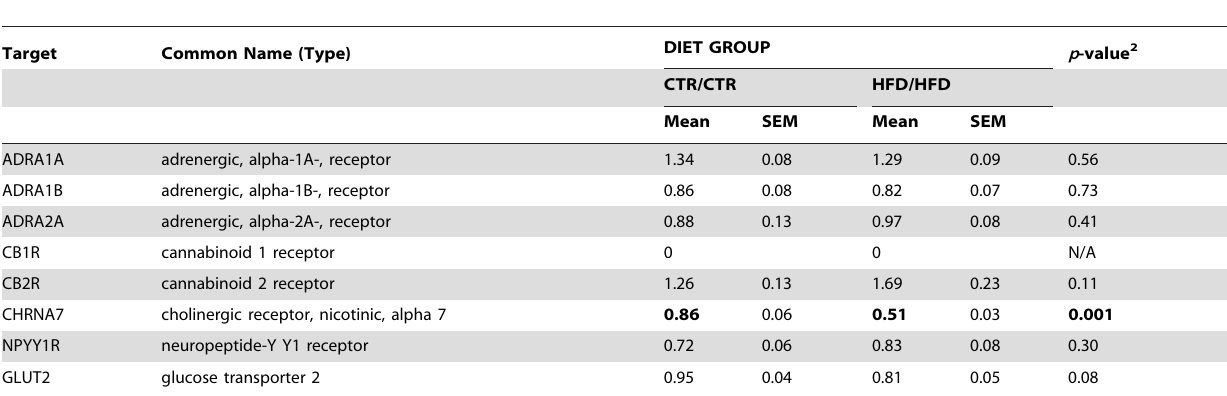
Table 3. Peripheral Nervous System mRNA expression in Juvenile Macaque Liver.